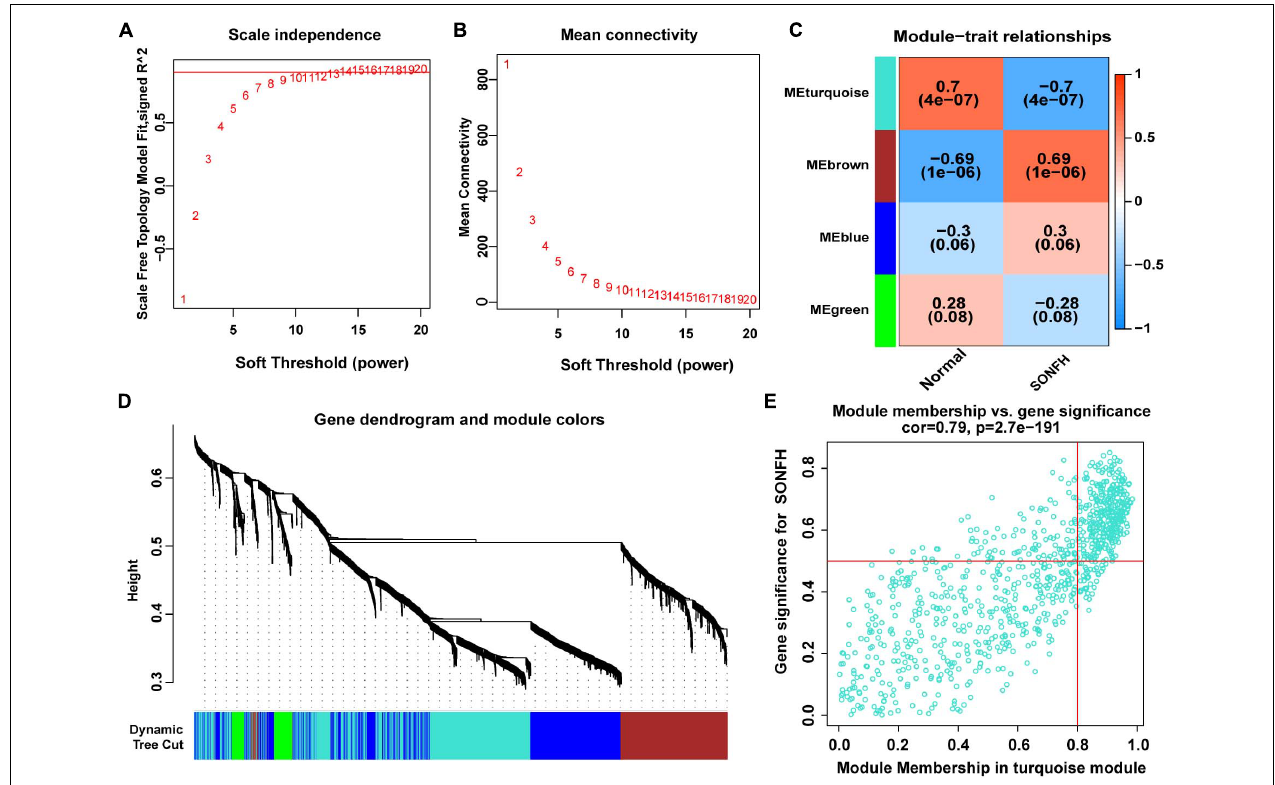
FIGURE 5 | WGCNA revealed gene co-expression networks in the whole peripheral blood of 40 SONFH patients. (A,B) Analysis of the scale-free fit index (left) and the mean connectivity (right) for various soft-thresholding powers. (C) Heatmap between the correlation between modules and SONFH (Each cell contained the correlation coefficient and corresponding P -value). (D) Clustering dendrogram of differentially expressed genes related to SONFH. (E) The gene significance for SONFH in the turquoise module (One dot represents one gene in the turquoise